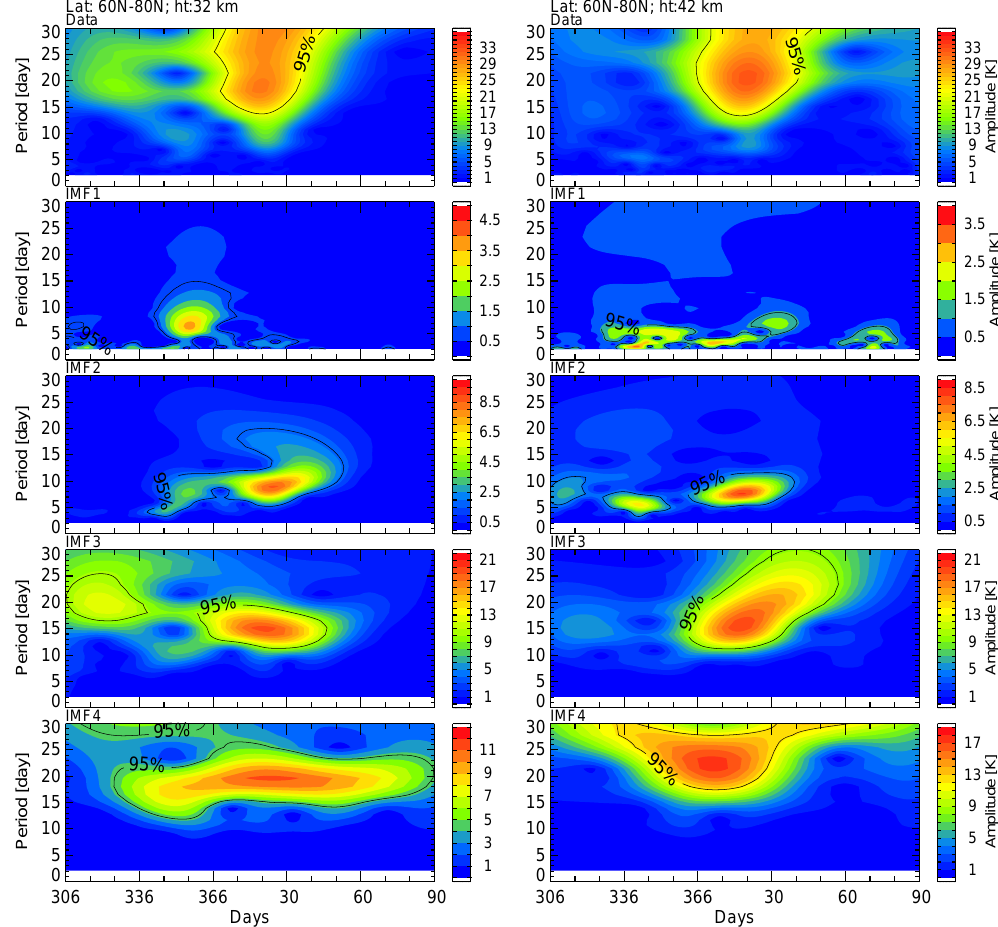
Fig. 5. Contours of wavelet intensities as a function of frequency and time for the temperature anomaly and first four IMFs shown in Fig. 4 over latitude range 60–80 ◦ N at both 32km (left panels) and 42km (right panels) altitude